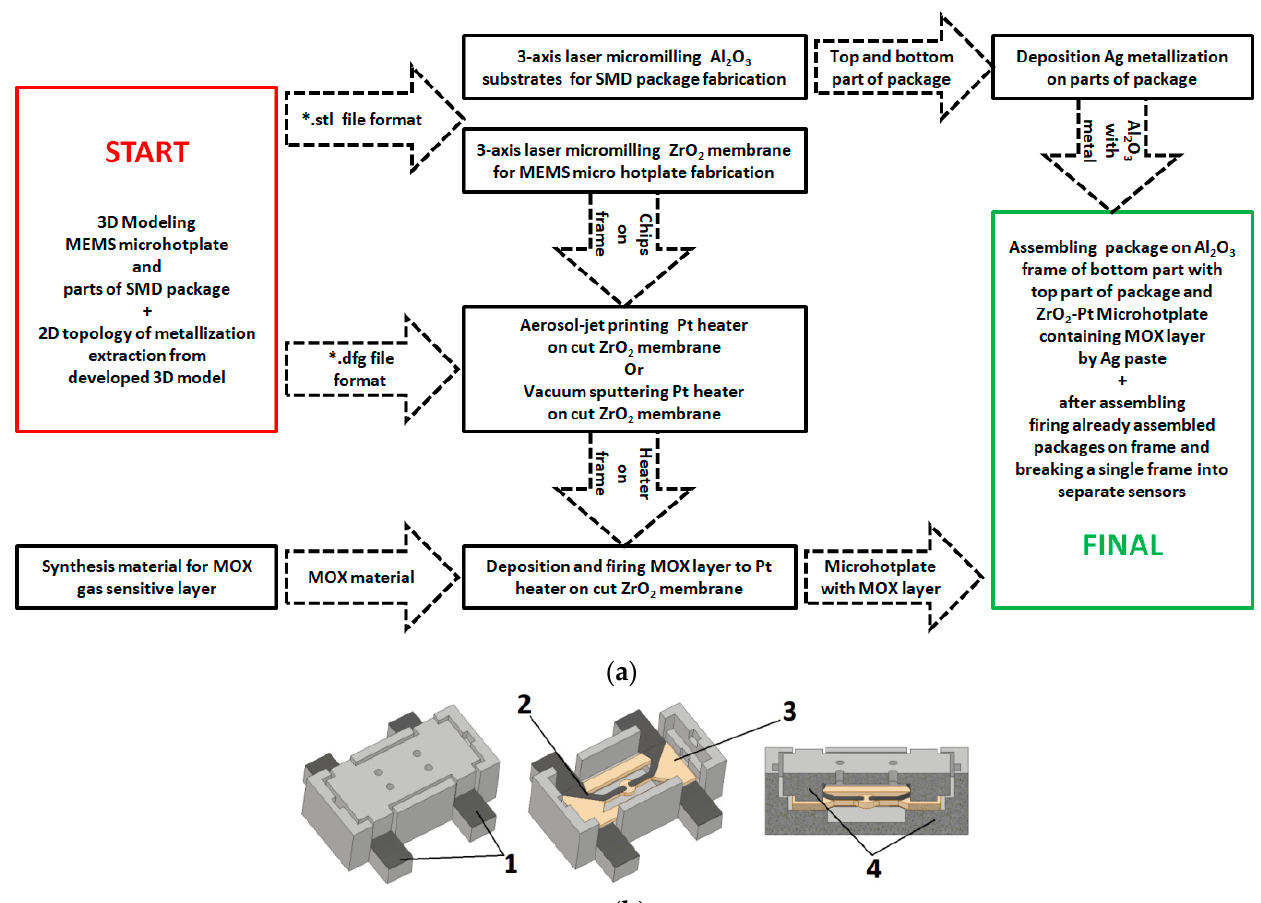
Figure 1. Digital technological flow used for rapid prototyping metal oxide (MOX)gas sensors: ( a ) Full flowchart for rapid prototyping of MOX gas sensors; ( b ) 3D model of gas sensor in the SOT-23 package using for fabrication: 1—Ag metallization; 2—Pt metallization; 3—YSZ membrane; and 4—Al 2 O 3 ceramics.